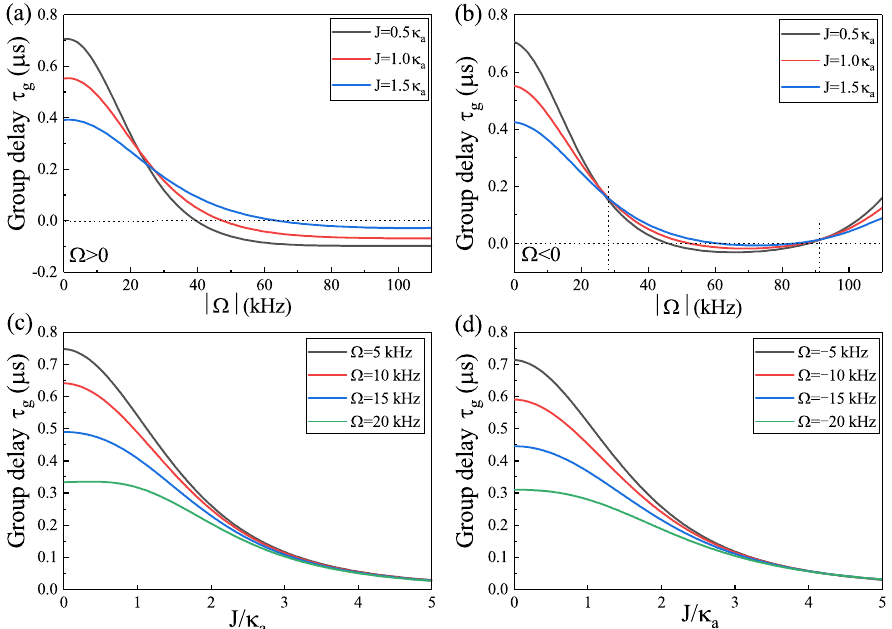
Figure 5. ( a ) The group delay varying with | Ω | in the case of Ω > 0 for three J . ( b ) The group delay varying with | Ω | in the case of Ω < 0 for three J . ( c ) The group delay varying with J for different angular velocities Ω along the CW direction ( Ω > 0). ( d ) The group delay varying with J for different angular velocities Ω spinning along the CCW direction ( Ω <